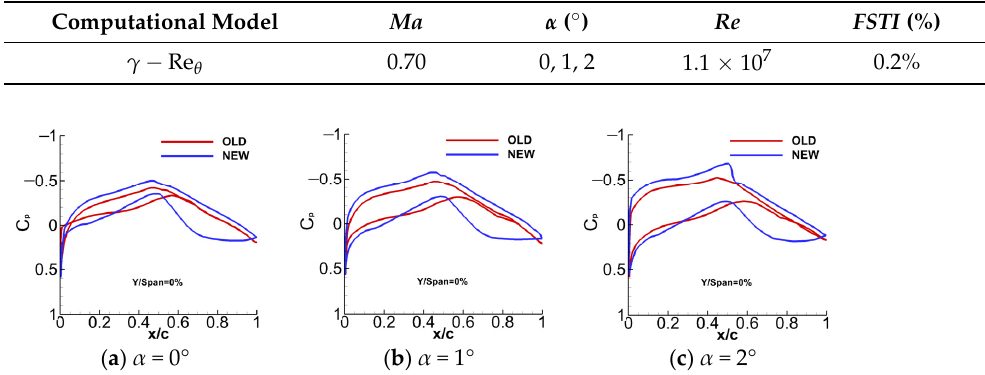
Table 7. Boundary conditions of the airfoil design.